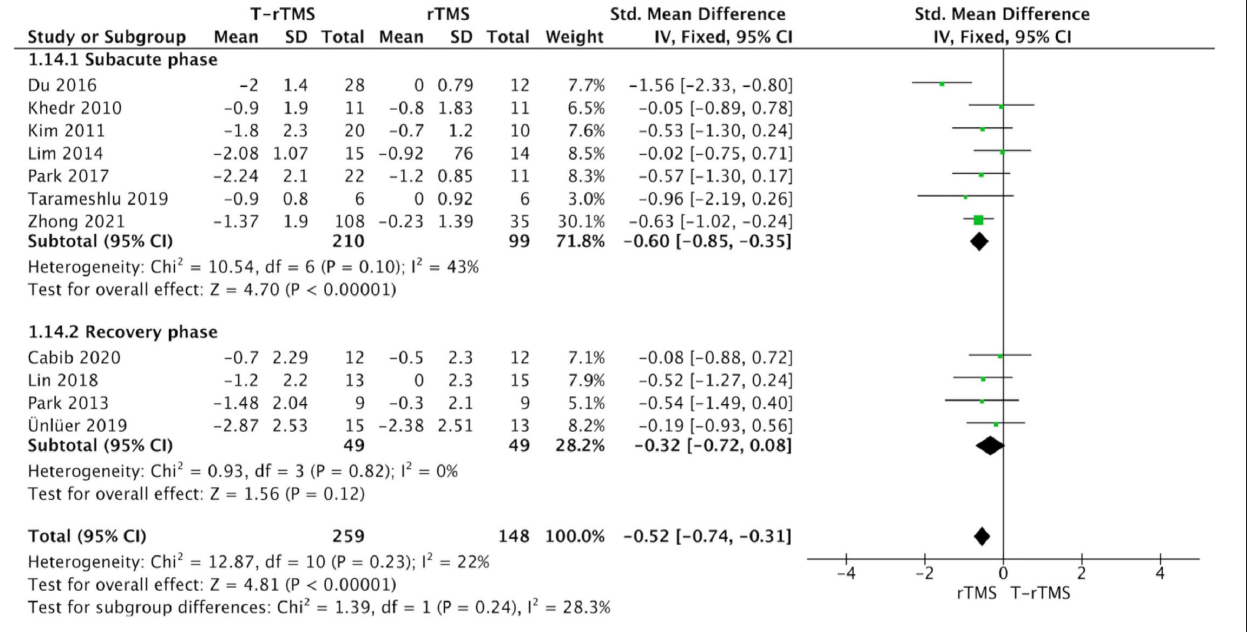
FIGURE 4 | Subgroup analysis of primary outcomes: forest plot of the standardized mean difference (SMD) for change scores in dysphagia severity rating scales by the different stroke stages. PSD, poststroke dysphagia; rTMS, repetitive transcranial magnetic stimulation; T-rTMS, the control group; Mean, Average volume reduction of upper extremities; SD, Sample standard